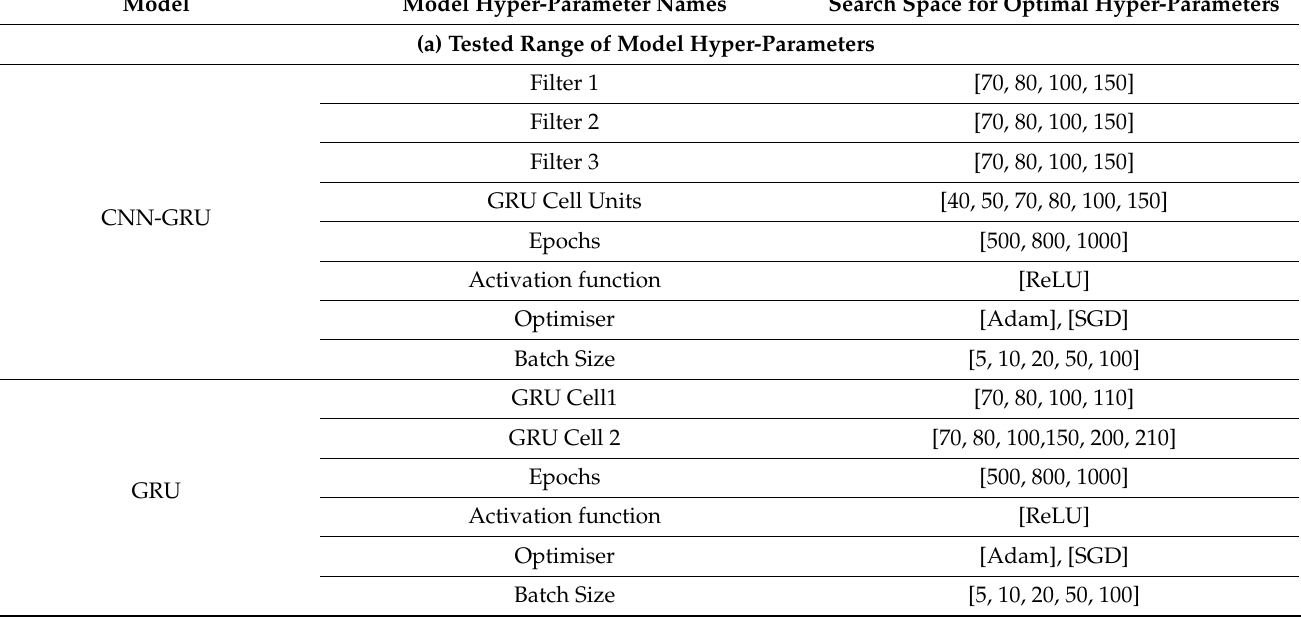
Table A2. (a) The full range of tested hyperparameters in designing the hybrid CNN-GRU and the GRU predictive model through an extensive grid search process. (b) Optimally selected